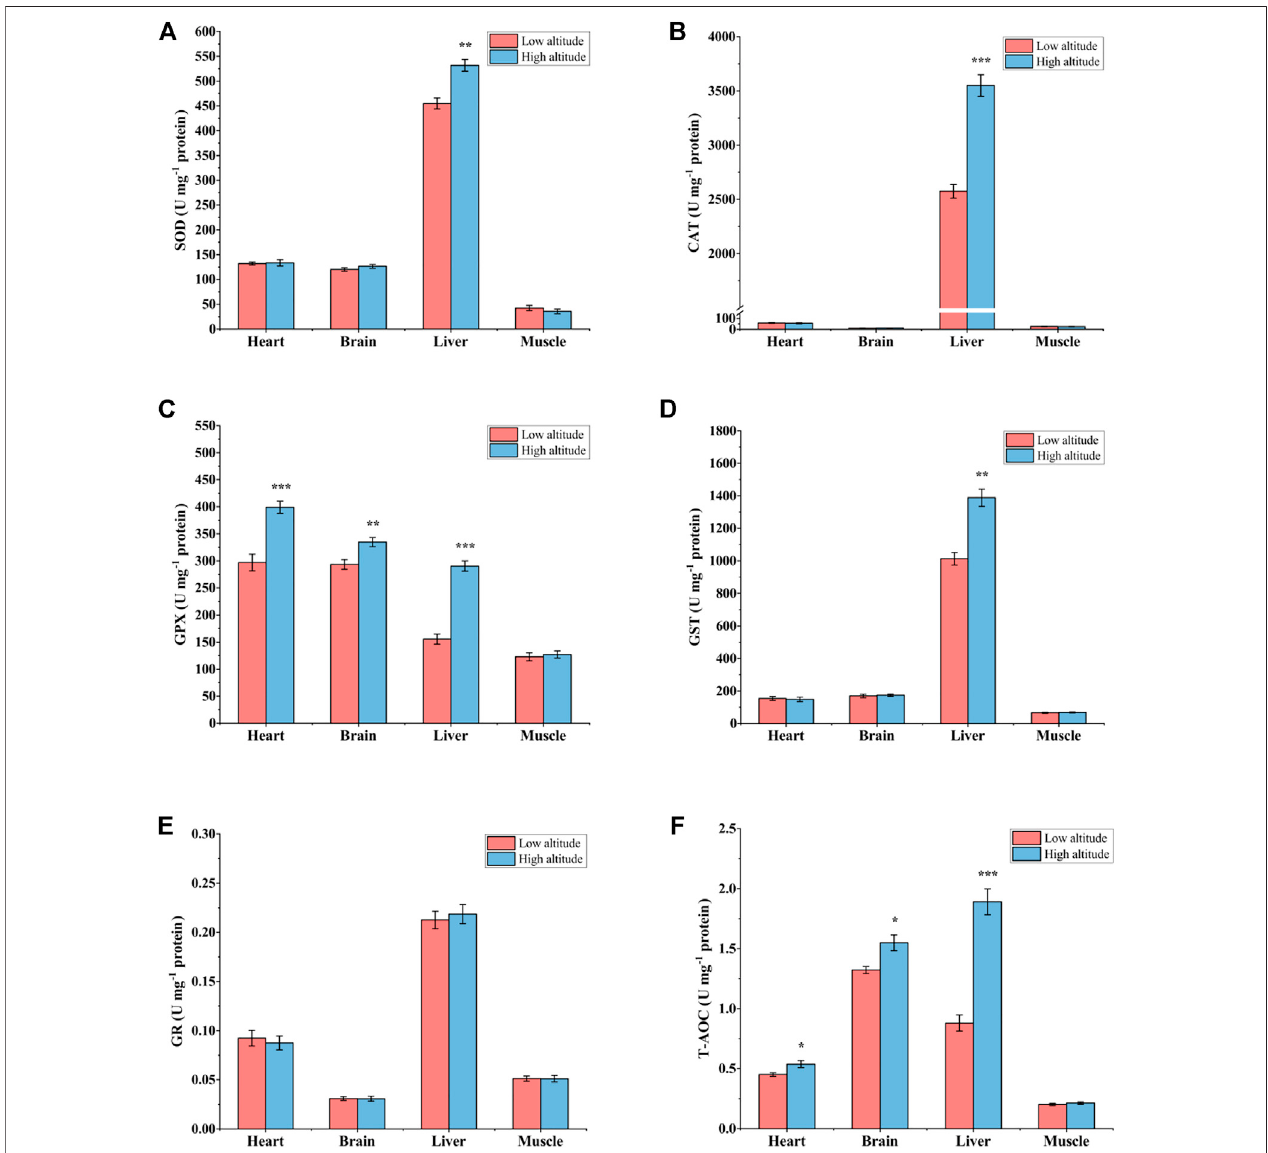
FIGURE 4 | Antioxidant enzyme activity and total antioxidant capacity (T-AOC) in heart, brain, liver, and muscle of low-altitude and high-altitude adult frogs. (A) superoxide dismutase (SOD) activity, (B) catalase (CAT) activity, (C) glutathione peroxidase (GPX) activity, (D) glutathione-S-transferase (GST) activity, (E) glutathione reductase (GR) activity and (F) total antioxidant capacity (T-AOC). Values are presented as mean ± SEM ( n = 8). Asterisks (* p < 0.05; ** p < 0.01; *** p < 0.001) indicate signi fi cant difference between two populations.